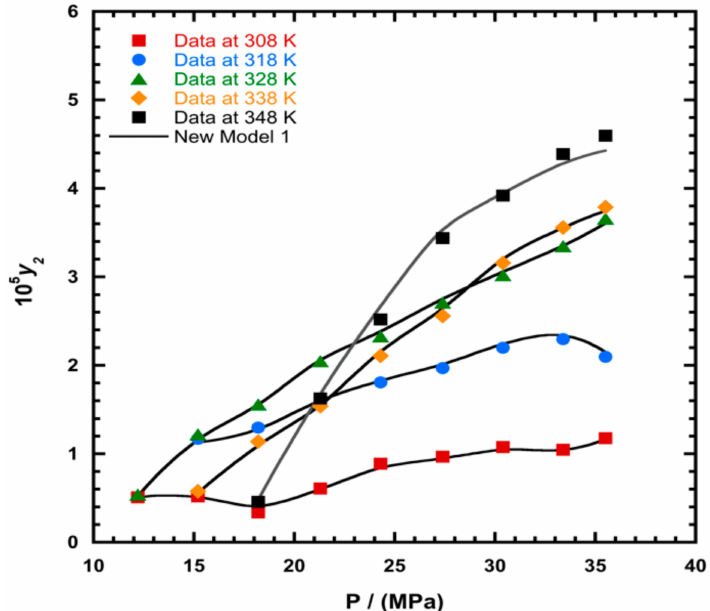
Figure 1. Plot of mole fraction ( y 2 ) as a function of pressure (P/MPa) for 1-amino-2,3-dimethyl-9,10- anthraquinone, the solid line represents the proposed model 1 (Equation